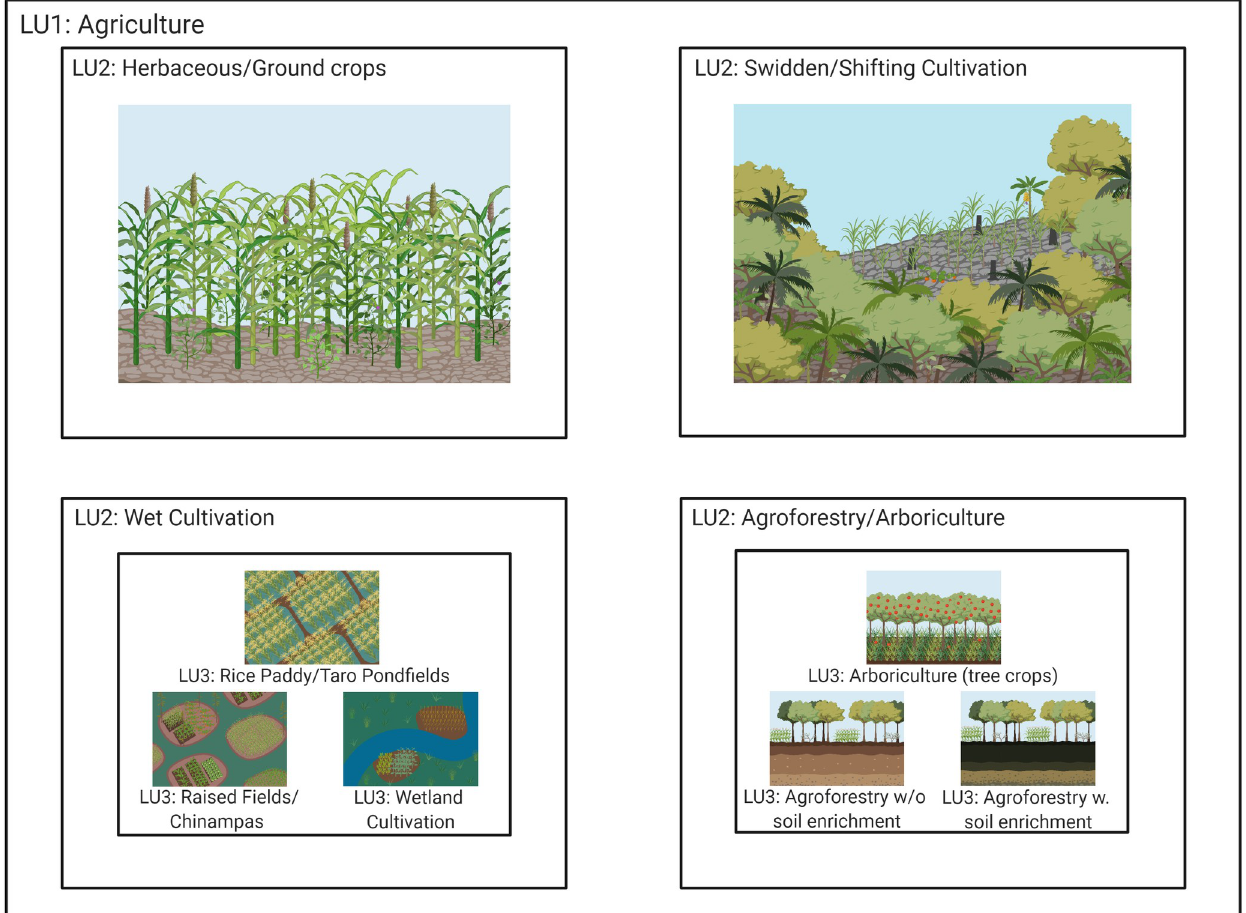
Fig 4. LU1-“agriculture” shown as several LU2 categories: LU2-“herbaceous/ground crops” is shown by agriculture of maize and millets (upper left). LU2-“swidden/shifting cultivation” is shown by forest clearance and cultivation of small crops in that space (upper right). LU2- “wet cultivation” (lower left) includes LU3 categories: LU3-“rice paddy/taro pond fields” represented by rice paddies, LU3-“raised fields/chinampas” shown by chinampa agriculture and LU3-“wetland cultivation” shown by cereal and pulse cultivation on river floodplains. LU2-“agroforestry/arboriculture” (lower right) includes LU3 categories: LU3-“arboriculture (tree crops)” shown with an apple orchard, LU3-“agroforestry” without soil enrichment shown through a woody perennial management system with undifferentiated soils from unexploited areas, and LU3-”agroforestry with soil enrichment of woody perennial management” with a Amazonian dark earth soil. Created with BioRender.com, under a CC BY license, with permission from Biorender, original copyright 2020.